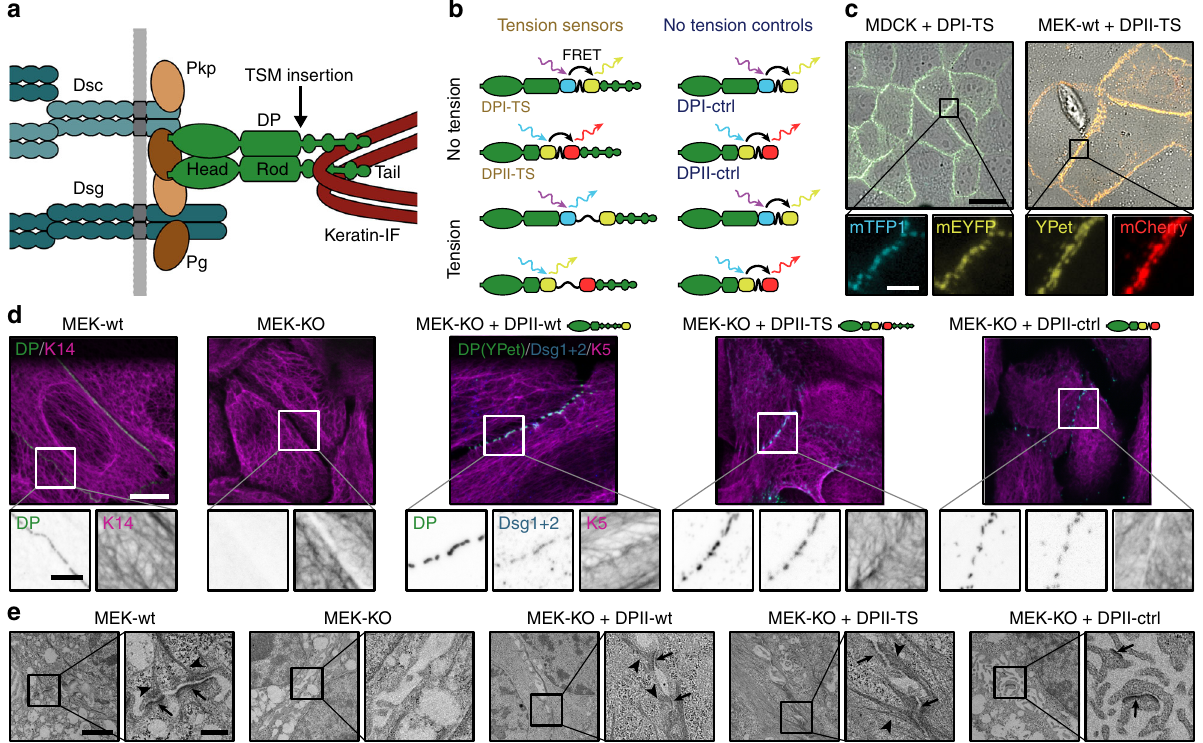
Fig. 1 Desmoplakin (DP) tension sensors localize to desmosomes (DSMs). a DSM adhesion is mediated by the desmosomal cadherins desmocollin (Dsc) and desmoglein (Dsg), which engage the adapter proteins plakophilin (Pkp) and plakoglobin (Pg); DP forms the connection to intermediate fi laments (IFs). The tension sensor module (TSM) was inserted into DP after the rod domain. b DP tension sensors (DPI-TS, DPII-TS) were generated along with controls lacking the IF-binding C-terminal region (DPI-ctrl, DPII-ctrl). The TSM comprises the F40 linker peptide (GPGGA) 8 fl anked by mTFP1/mEYFP in DPI, and YPet/mCherry in DPII. Tension reduces FRET in DP-TS but not in DP-ctrl constructs. c Live-cell imaging reveals normal subcellular localization of DPI-TS (expressed in MDCK cells) and DPII-TS (expressed in MEK-wt one day after DSM induction by Ca 2 + ). Scale bar: 20 μ m; in zoom: 4 μ m. d DPII constructs localize to intercellular junctions in MEK-KO one day after DSM induction, similar to endogenous DP in MEK-wt. Immunostainings show that DPII constructs co-localize with Dsg1/2, and that full-length constructs but not DPII-ctrl mediate the recruitment of a coherent keratin 5 (K5) network. Images are summed projections of nine optical slices covering 3.1 μ m. Scale bars: 10 μ m; in zoom: 4 μ m. e Ultrastructural analysis of MEKs one day after DSM induction reveals that the expression of DPII-wt and DPII-TS but not DPII-ctrl rescue both the DSM formation (arrows) and IF attachment (arrow heads) defects of MEK-KO. Electron microscopy images are contrast adjusted. Scale bars: 2 μ m; zoom: 0.5 μ